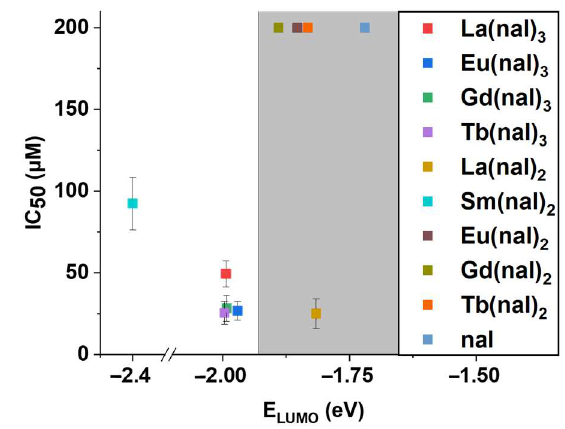
Figure 8. Graphical representation of IC 50 ( µ M) vs. E LUMO (eV); IC 50 values were calculated for the LoVo cell line, and results > 200 µ M were attributed the value 200 on the graph; grey area shows compounds with low activity (note that La(nal) 2 represents the exception).